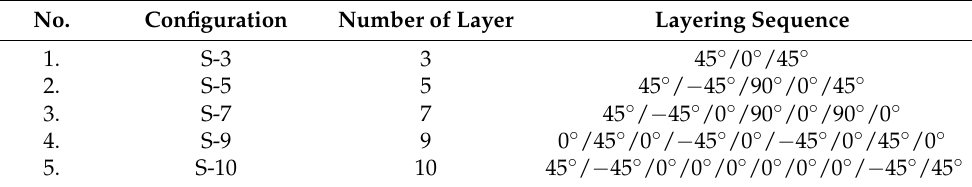
Figure 2. Stacking sequence of pGFRP composite samples such as ( a ) S-3, ( b ) S-5, ( c ) S-7, ( d ) S-9 and ( e ) S-10. Table 1. Configuration of glass fibre/UPE composites.